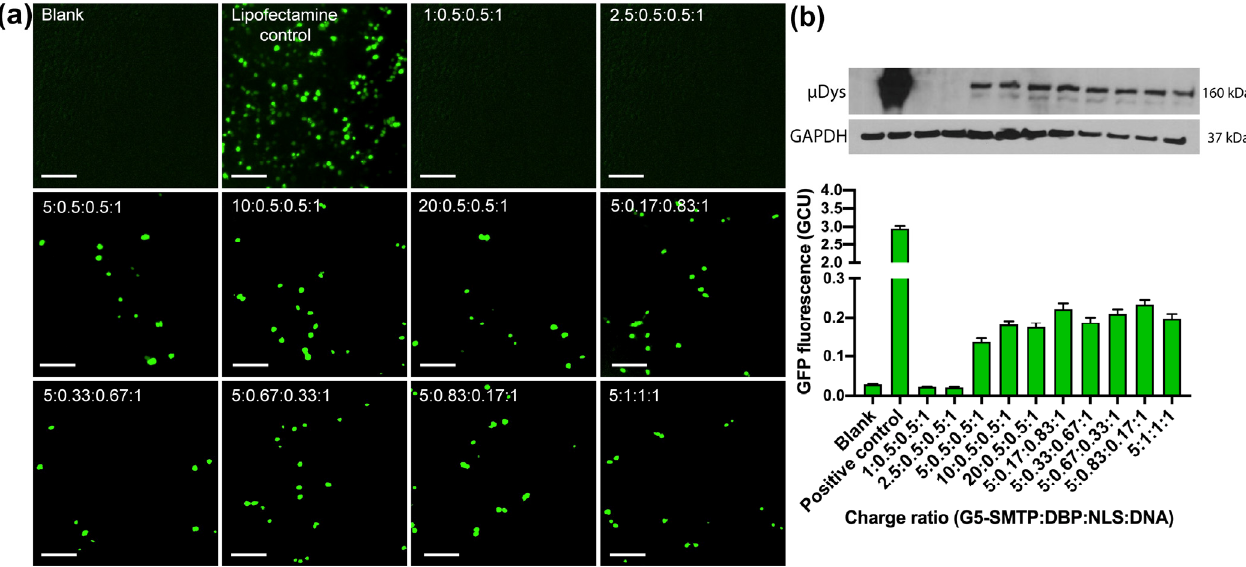
Figure 5. HEK 293T cells were treated with the polyplexes formed at various charge ratios, and the EGFP and µDys expression was quantified after 48 h. ( a ) Representative fluorescent images for EGFP expression. Scale bar: 300 µm. ( b ) Quantification of EGFP fluorescence and Western blotting for microdystrophin. EGFP signal was normalized to the cellular area. The blots follow the same loading and charge ratios as the graph.